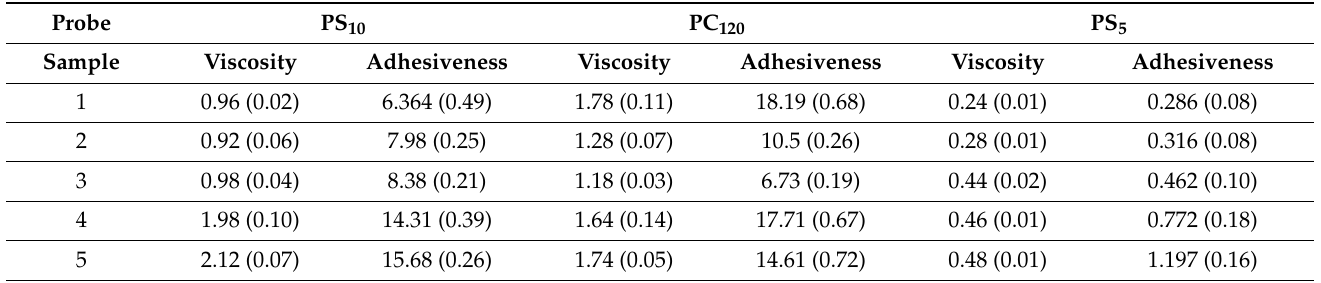
Table 6. Texture parameters (mean–SD) of analyzed